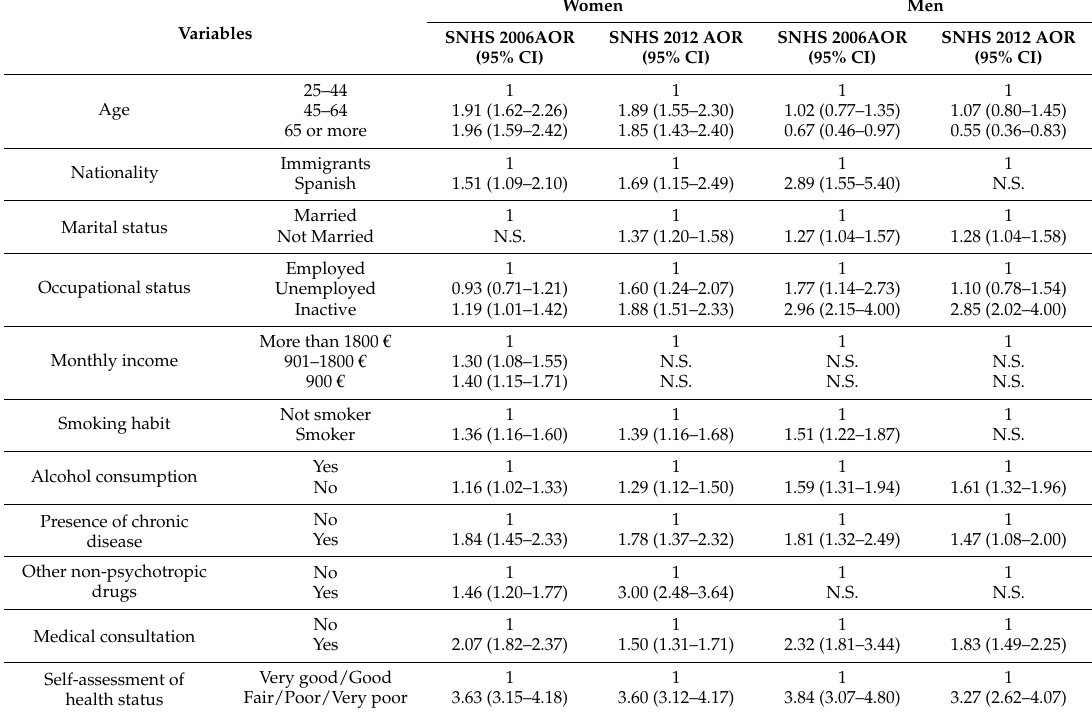
Table 3. Multivariate models for associations between psychotropic drugs use and sociodemographic variables, lifestyle, health profile and healthcare resources. Spanish National Health Surveys 2006 and